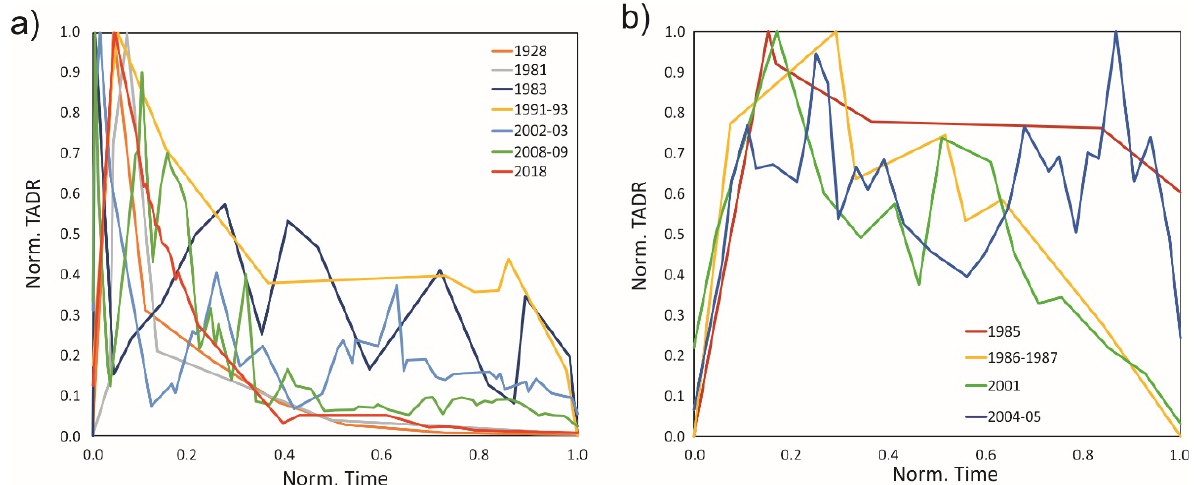
Figure 4. Diagrams showing the filtered, convoluted and normalized TADRs, where two trends can be recognized: ( a ) Trend 1, characterized by effusion rate peaks between the first 0.5% and 5% of the total eruption duration, followed by a decrease in the TADRs with an exponential trend; ( b ) Trend 2, where the effusion rate peak is observed between 15% and 29% of the total eruption duration, followed by a more progressive decrease of the TADR.